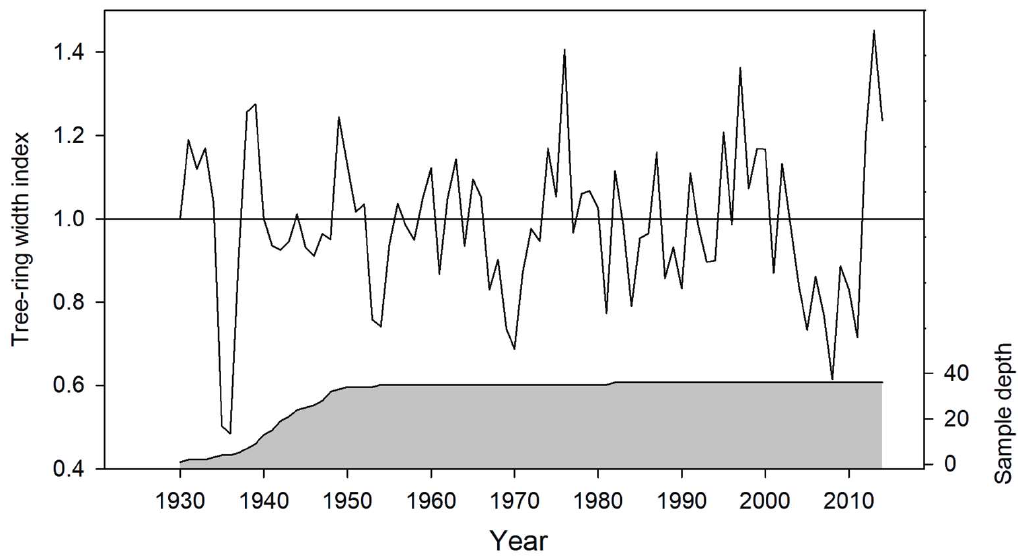
Figure 3. Tree-ring width chronology and sample depth.